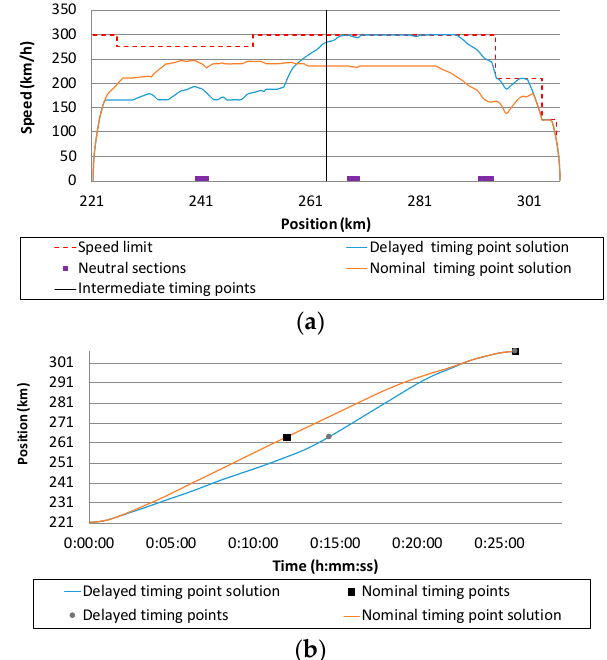
Figure 13. Speed profile ( a ) and position evolution with time ( b ) of the solution found by the algorithm for the case of one intermediate delayed timing point.